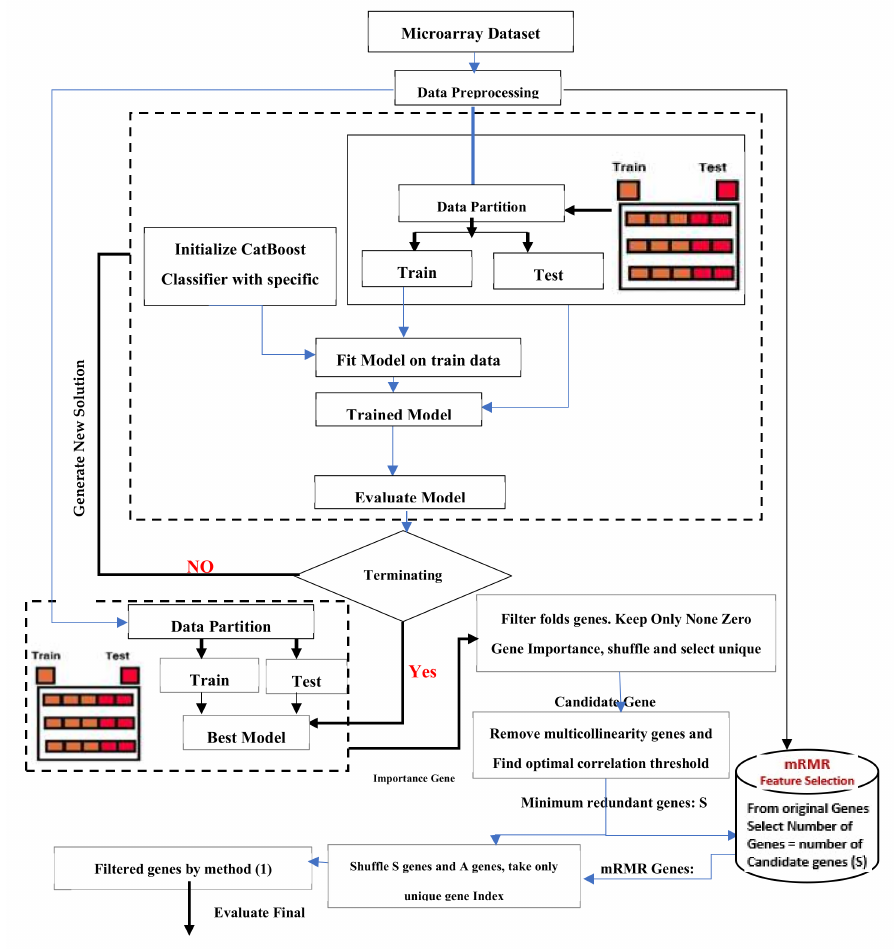
Figure 3. The proposed hybrid model. Table 3. Parameter